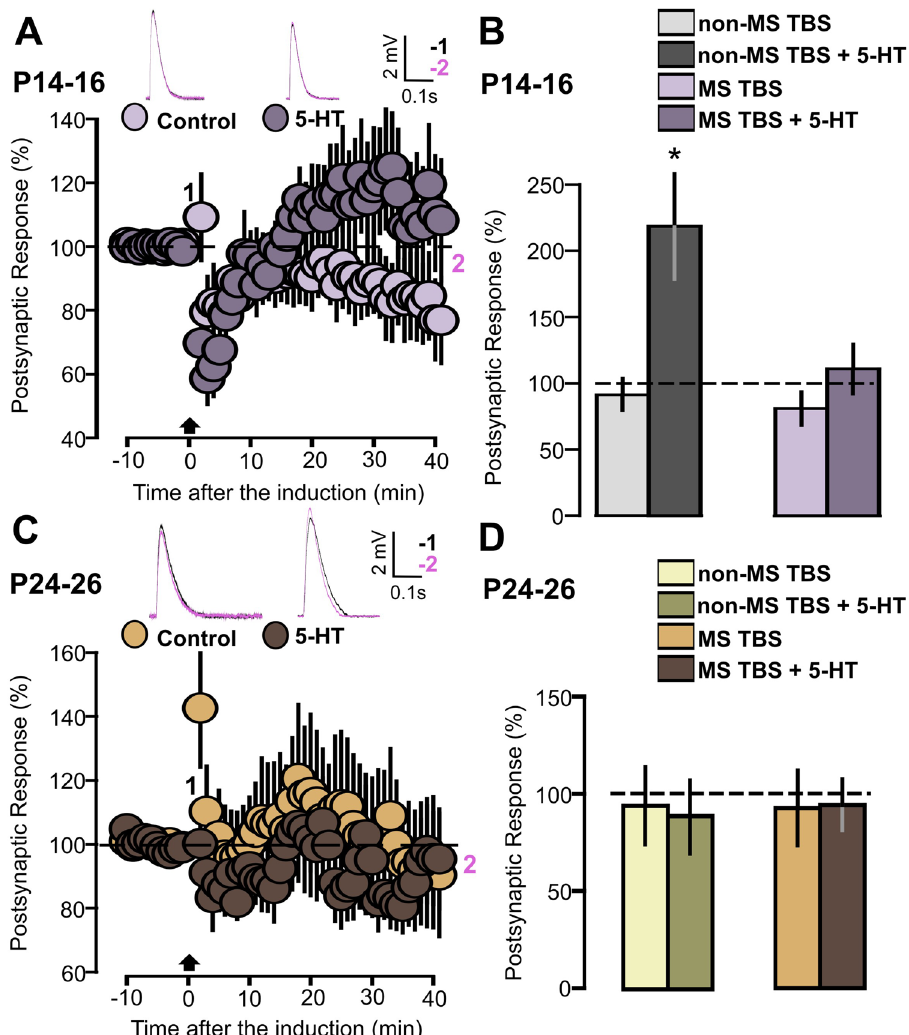
Figure 12. TBS induction fails to induce synaptic plasticity in slices from MS animals. ( A ) The graph shows the EPSPs recorded in MS P14-16 animals before and after TBS induction. The EPSPs were normalized to the mean of responses recorded during the baseline, with two different conditions being compared: control (light violet) and 5-HT (dark violet, 50 µM). Traces show the results of a representative experiment with the average of postsynaptic responses recorded before (1: baseline, − 5 to 0 min, black line) and after the TBS induction (2: post induction, 35–40 min, magenta line). ( B ) Graph showing the averaged EPSPs recorded during the 35–40 min period after TBS induction in P14-16 animals. Four experimental groups are compared (non-MS TBS, non-MS TBS + 5-HT, MS TBS, MS TBS + 5-HT). ( C ) The graph shows the EPSPs recorded in MS P24- 26 animals before and after TBS induction. The EPSPs were normalized to the mean of responses recorded during the baseline, with two different conditions being compared: control (beige inserts) and 5-HT (dark brown inserts, 50 µM). Traces show the results of a representative experiment with the average of postsynaptic responses recorded before (1: baseline, − 5 to 0 min, black line) and after the TBS induction (2: post induction, 35–40 min, magenta). ( D ) Graph showing the averaged EPSPs recorded during the 35–40 min period after TBS induction in P24-26 animals. Four experimental groups are compared (non-MS TBS, non-MS TBS + 5-HT, MS TBS, MS TBS +